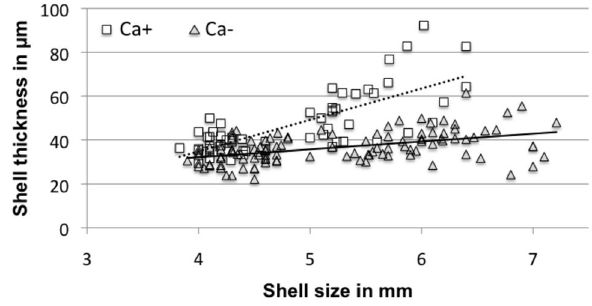
Figure 5. Linear regressions analysis using shell thickness and shell size in adult Notodiscus hookeri .